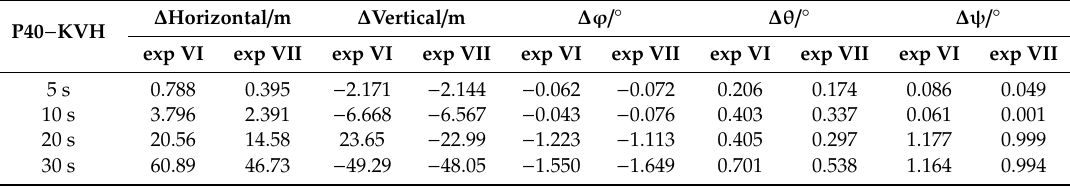
Table 4. The di ff erence values of the horizontal and vertical position, roll, pitch and yaw between GNSS / IMU-P40 (our program in a 15-state Kalman filter) and GNSS / KVH coupled navigation (IE software), at di ff erent epochs of the seconds of GNSS blocked in experiments VI and VII.